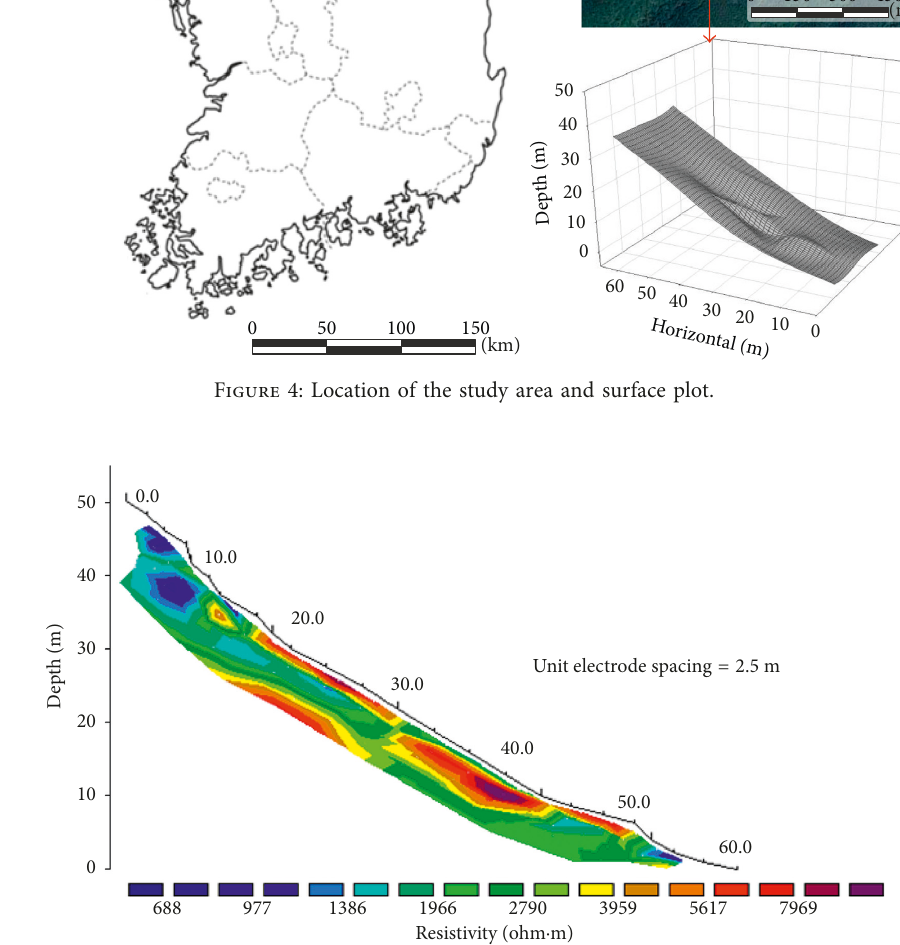
Figure 5: Resistivity tomography of the